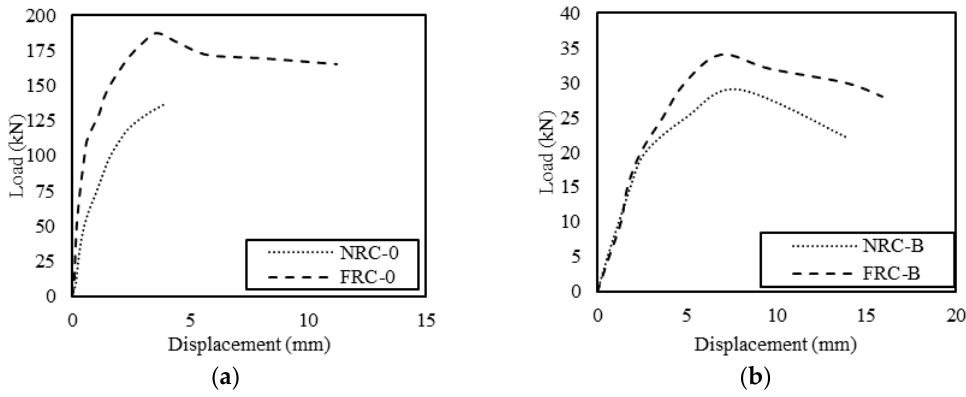
Figure 8. Load – axial deformation of NRC-0 and FRC-0 ( a ) columns and ( b ) beams. Figure 8. Load–axial deformation of NRC-0 and FRC-0 ( a ) columns and ( b ) beams.